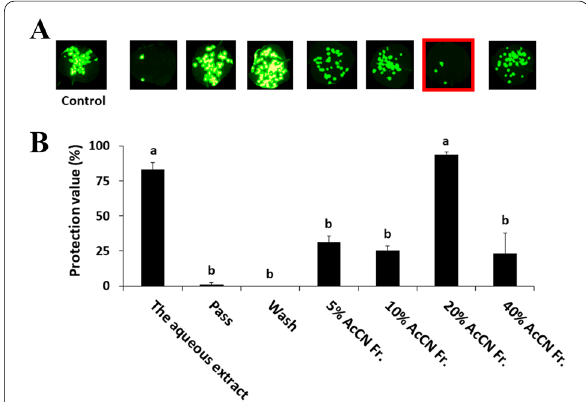
Fig. 1 Antiviral activities of fractions of A. zerumbet extract separated by reverse-phase chromatography. The concentration of each fraction used in the application of samples to N. benthamiana leaves was adjusted to be the concentration of the original solution. N. benthamiana leaves were inoculated with GFP-tagged ToMV, and treated with extract samples or fractions separated by a C18 Sep-Pak ® cartridge. A GFP foci formed at 3 days post-inoculation (dpi). Images were taken under blue light irradiation using the ChemiDoc ™ MP Imaging System (Bio-rad, Hercules, CA, USA). B The GFP spots formed on the inoculated leaves were counted at 3 dpi. Protective value (%) (1 number of GFP spots on the treated plants/number of GFP = − spots on the control plants) 100. Different letters (a and b) indicate × significant differences between the control and treated plants at each leaf position by one-way ANOVA with the Tukey–Kramer method ( p < 0.05)